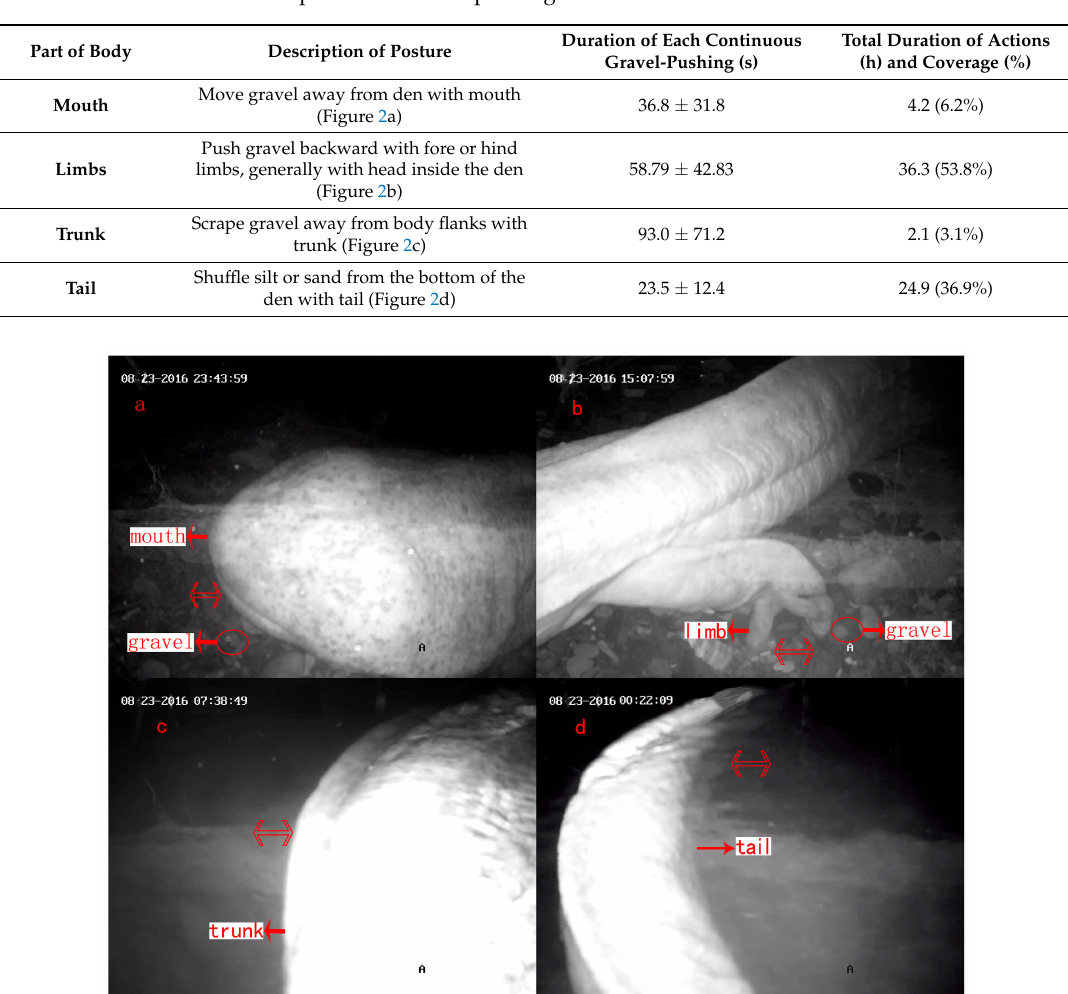
Table 1. Description of the sand-pushing behavior of male Andrias davidianus .